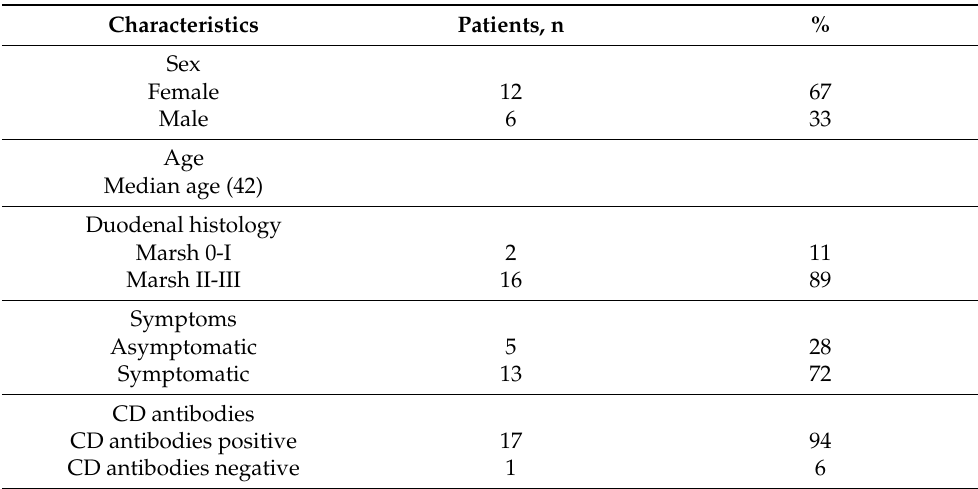
Table 2. Characteristics of the patients enrolled in the study. CD, celiac disease.